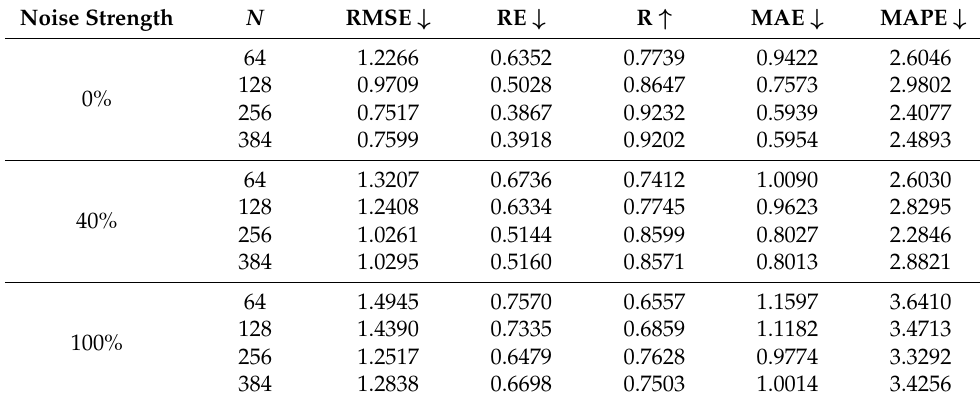
Table 5. Quantitative analysis on different time windows as